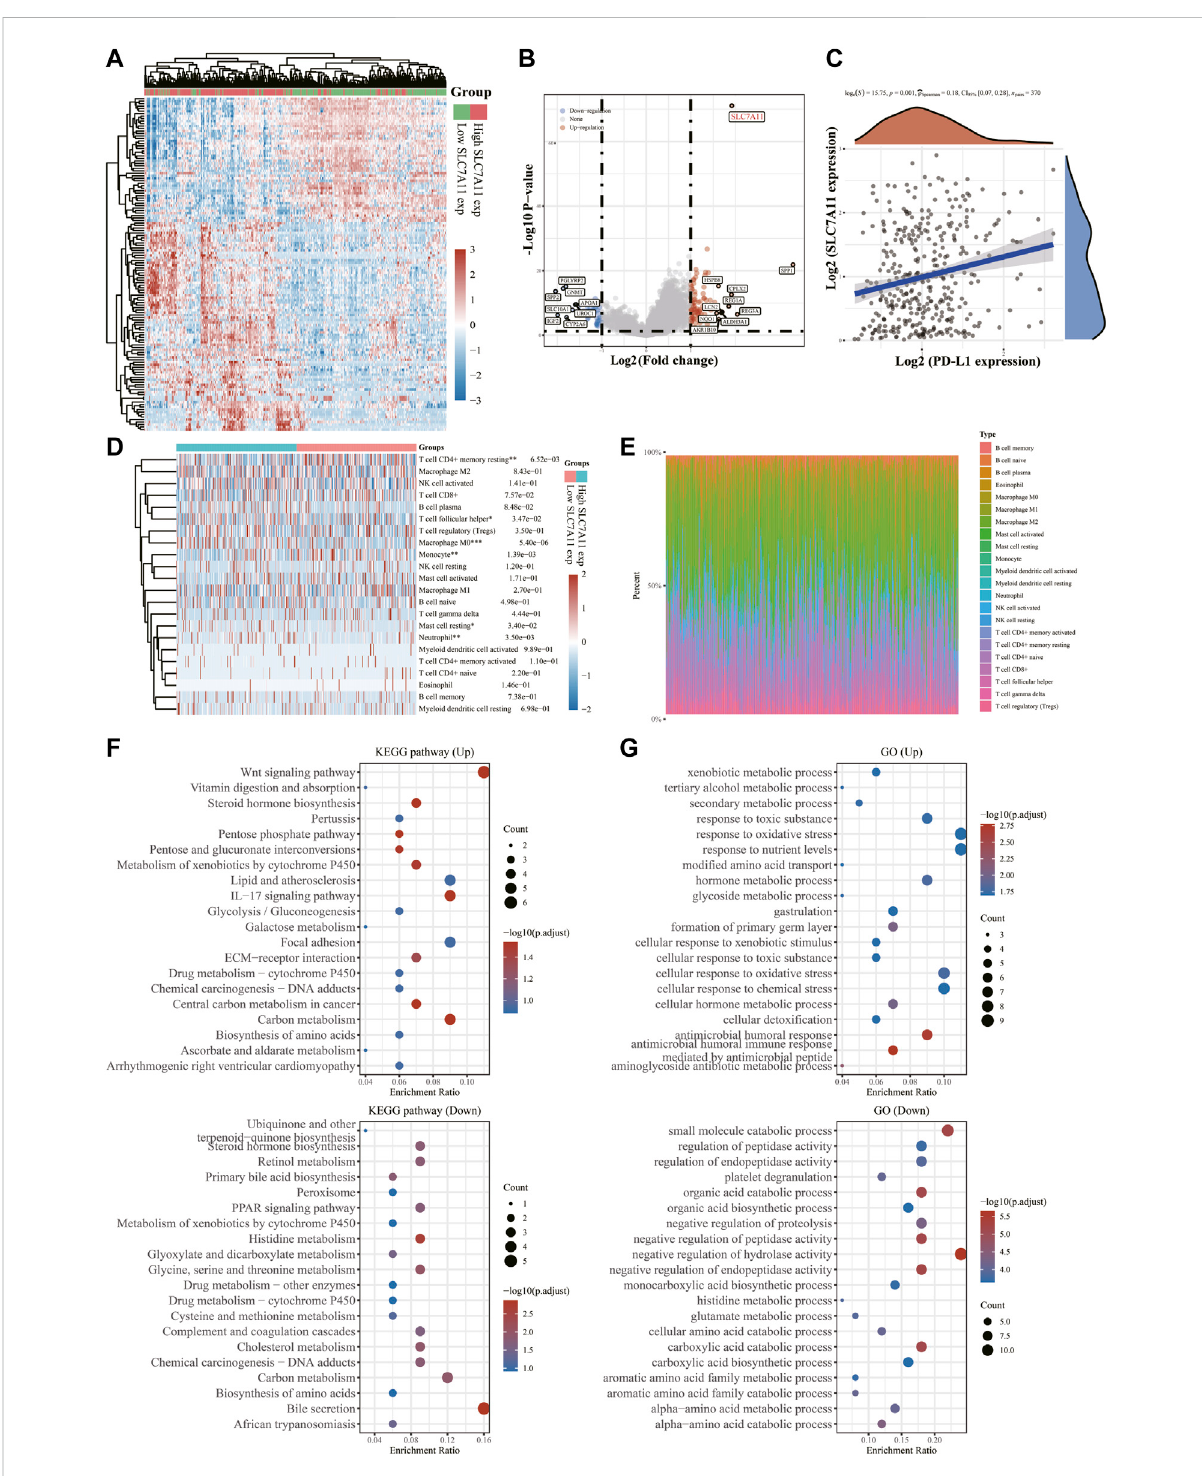
FIGURE 6 Differential expressionsofSLC7A11 inLIHCanditscorrelationwithPD-L1andimmunein fi ltration. (A) Heatmapofdifferencesinhigh-andlow- SLC7A11 expression groups. (B) Volcano plot of up- and down-regulated DEGs between the high- and low-SLC7A11 expression groups. (C) Correlation analysis of SLC7A11 and PD-L1 expression. (D) Immune cell in fi ltration pro fi les and relative proportions (E) in groups of different SLC7A11 expressions. (F) KEGG bubble charts of up- and down-regulated DEGs. (G) GO bubble charts of up- and down-regulated DEGs. * p < 0.05, ** p < 0.01, and *** p <